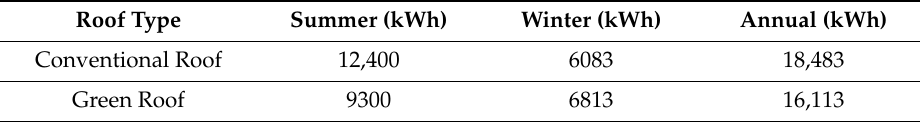
Table 4. Annual energy consumption for the conventional and green roof.